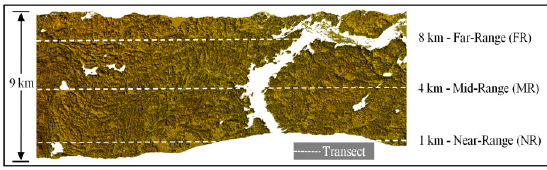
Figure 5. Transect line (dashed line) positions in near-, mid-, and far-range for one strip of X-HH InSAR data.